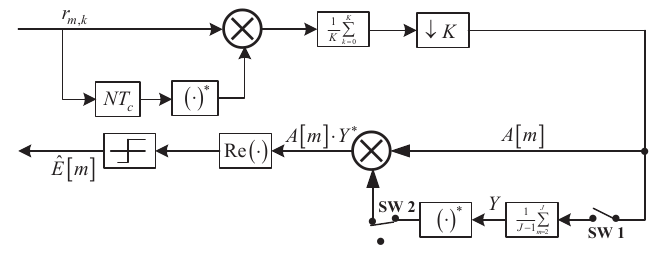
Figure 1. The optimal receiver